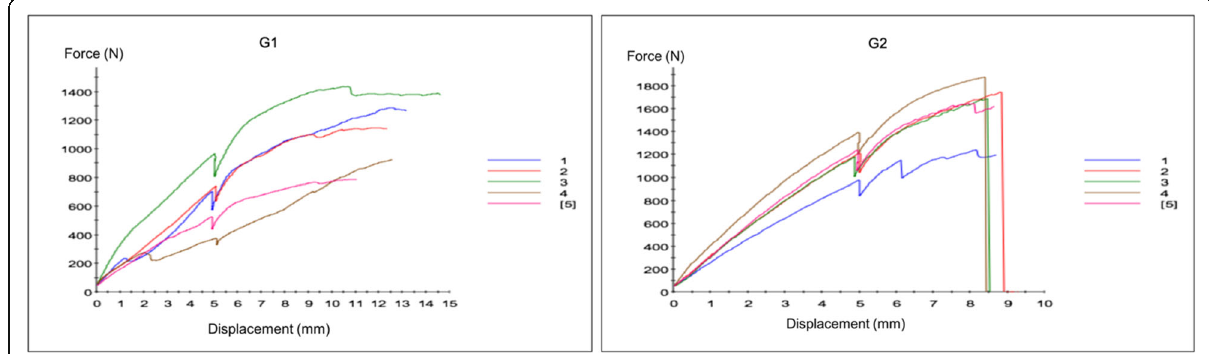
Fig. 5 a . Group 1 (assembly with two parallel cannulated screws at the bottom of the femoral neck + Pauwels screw): force versus displacement curves for the five specimens analyzed; b . Group 2 (assembly with two parallel cannulated screws at the bottom of the femoral neck + Pauwels screw + medial plate): force versus displacement curves for the five specimens analyzed